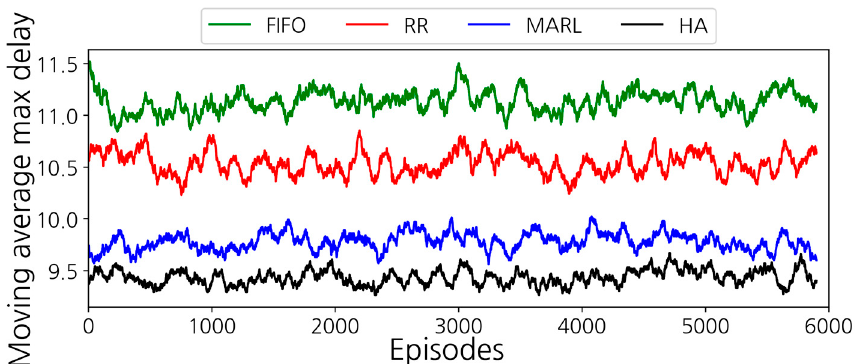
Figure 16. Moving average of maximum end-to-end latency per scheduler when random flows are generated in topology 4.